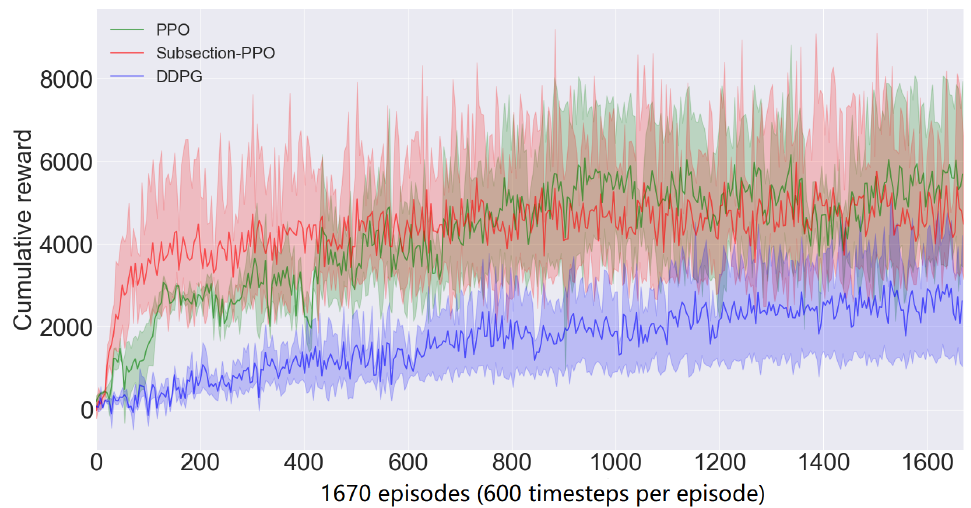
Figure 4. Cumulative rewards.